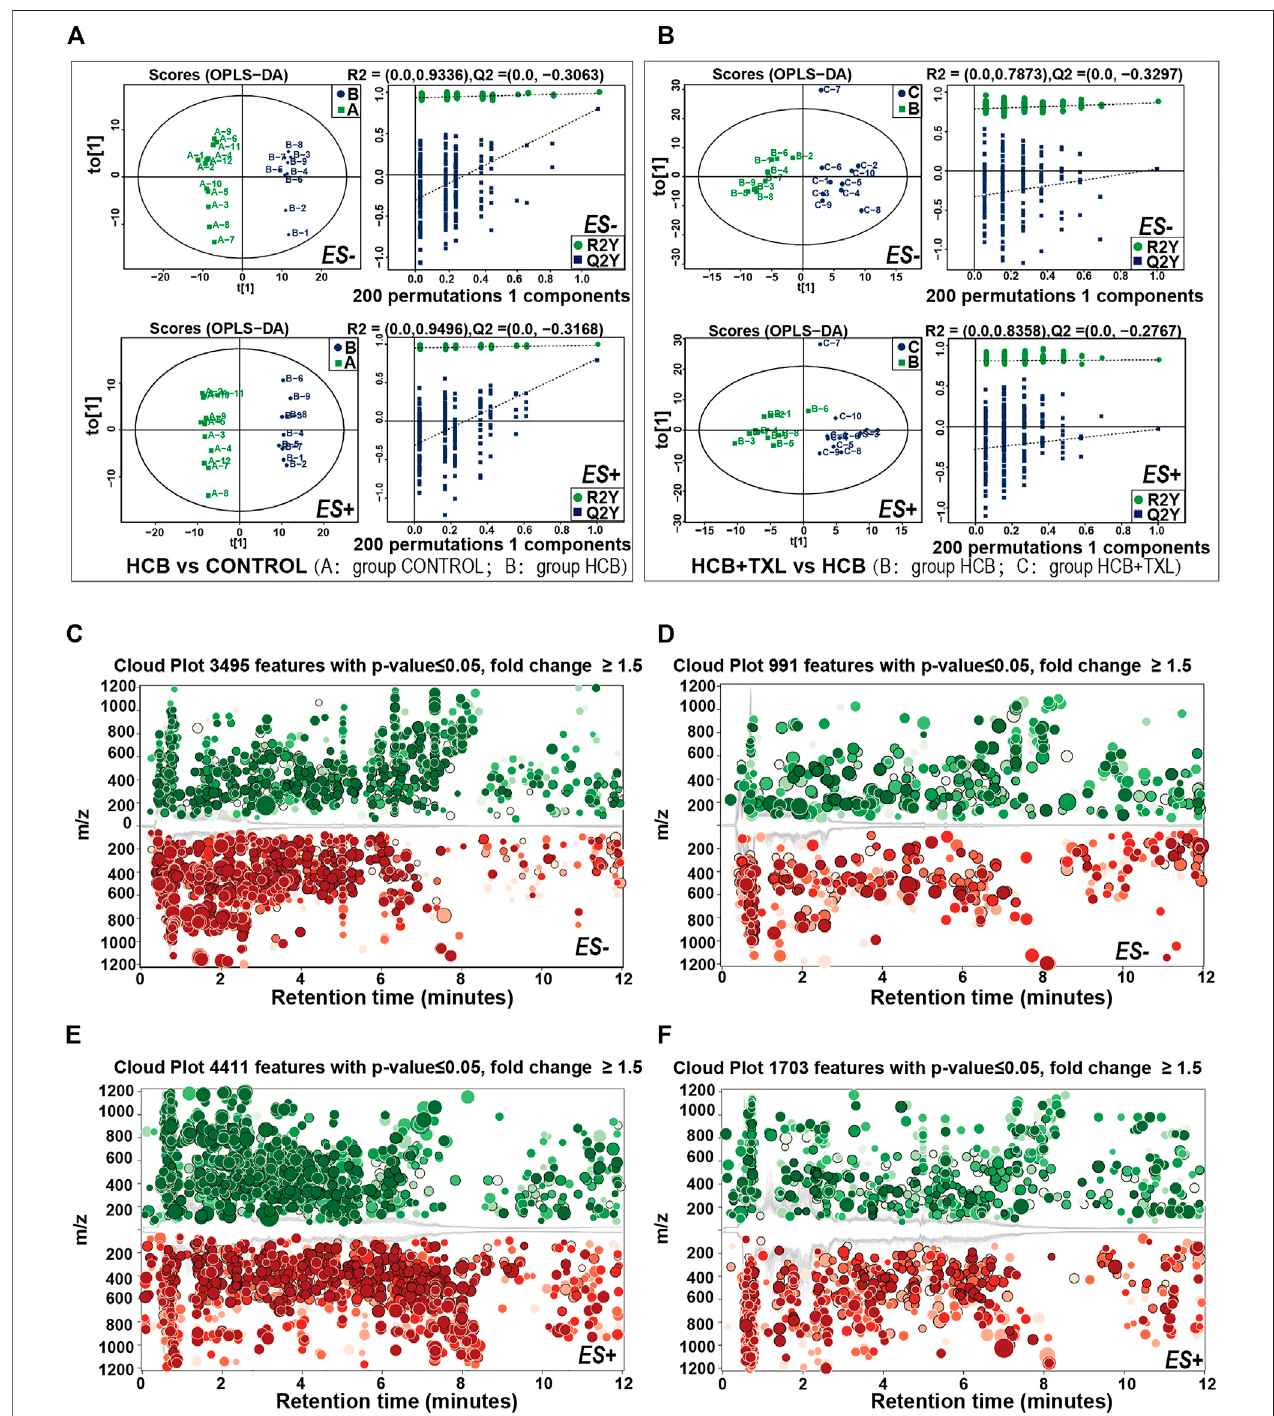
FIGURE 5 | High-performance liquid chromatography-mass spectrometry explored the intestinal metabolic pro fi ling (A,B) The plots of OPLS-DA scores of all peak featuresinpositive(ES+)andnegative(ES-)ionmodesfromtheuntargetedmetabolomicsanalysisofstoolsamplesoftherabbitsinCONTROL(n=12),HCB(n=9)andHCB +TXL12wgroups.ValidationoftheOPLS-DAmodelviapermutationtest(times=200).R2measuresthegoodnessof fi tandQ2measuresthepredictiveabilityofthemodel. ThecriterionformodelvalidityisthattheregressionlineoftheQ2-points(bluedottedline)intersectstheverticalsolidline(ontheleft)belowzero (C,E) Cloudplotsofthe peakfeaturesofintestinalmetaboliteswhichsigni fi cantlychangedinHCBgroup(n=9)comparedwiththoseofCONTROL(n=12)groupinnegativeionmode(ES-)(C)and positiveionmode(ES+) (E)(D,F) Cloudplotsofthepeakfeaturesofintestinalmetaboliteswhichsigni fi cantlychangedinHCB+TXL12wgroup(n=10)comparedwiththose of HCB group in negative ion mode (ES-) (D) and positive ion mode (ES+) (F) . Red and Green circles indicate the signi fi cantly increased and decreased metabolites, respectively,(foldchange > 1.5, p < 0.05).Thecolortoneindicates p -value:adarkcolorindicatesasmall p value.Thecircleradiusindicatesthefoldchangeofcorresponding peak